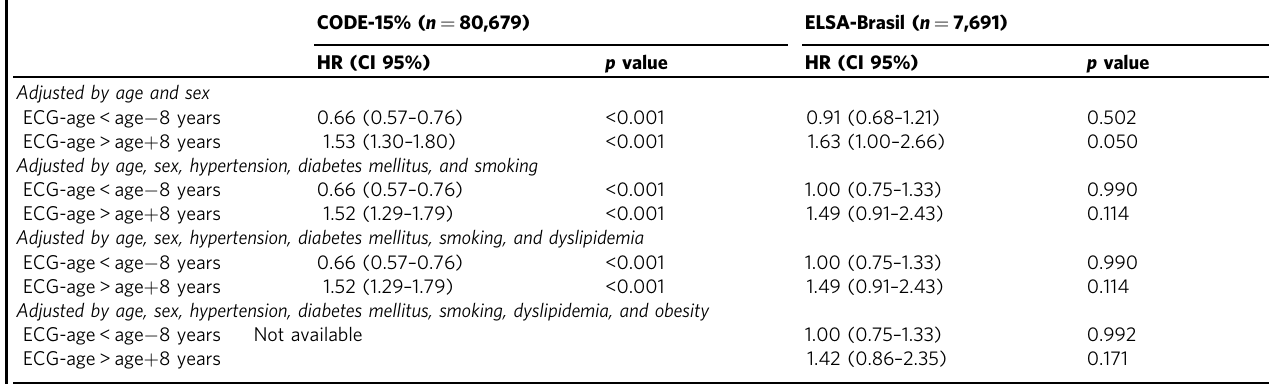
Table 4 Hazard Ratios for normal